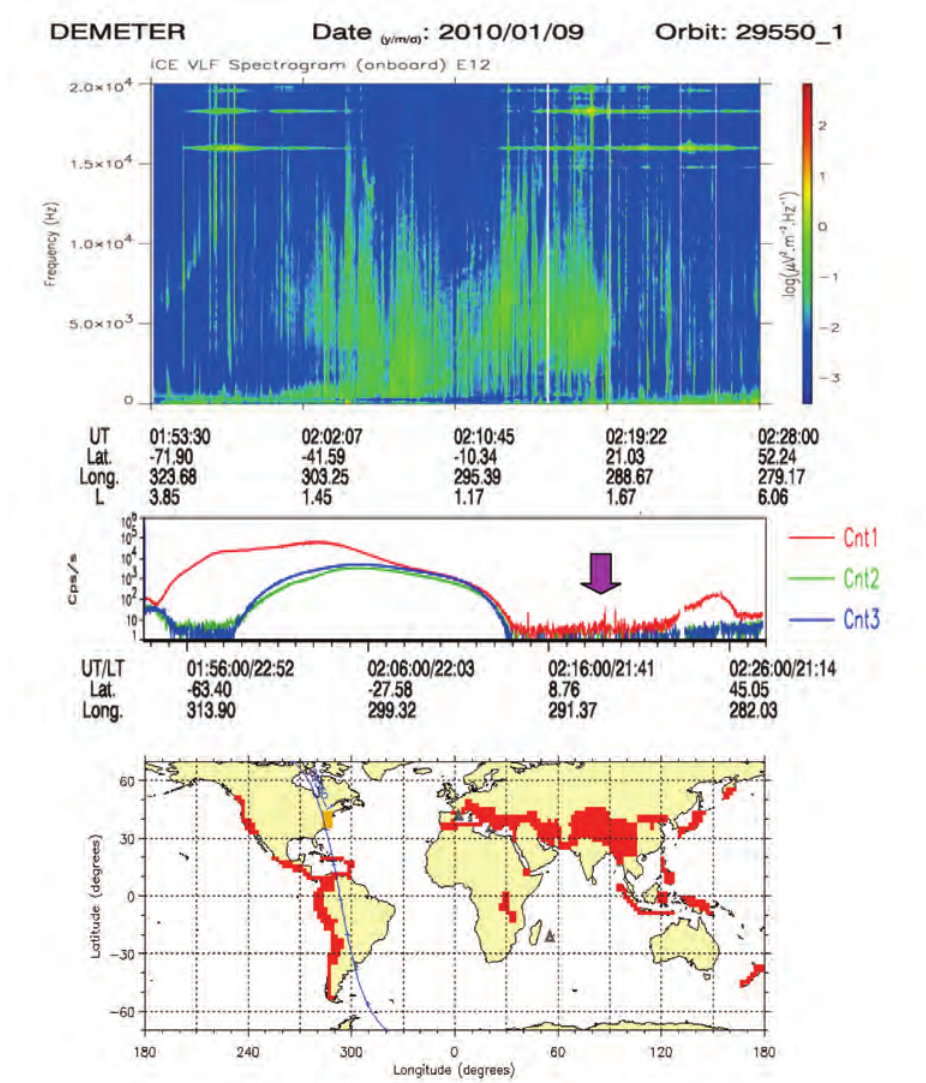
Figure 4. Observations from the DEMETER saellite on January 12, 2010, about 3 days before the Haiti earthquake occurred at 21:53 on January 12, 2010 (18.46˚N/287.47˚E). A pair of short-lived peaks were observed that were separated by a time interval of ~1 min, and were accompanied VLF (~2-10 kHz) wave